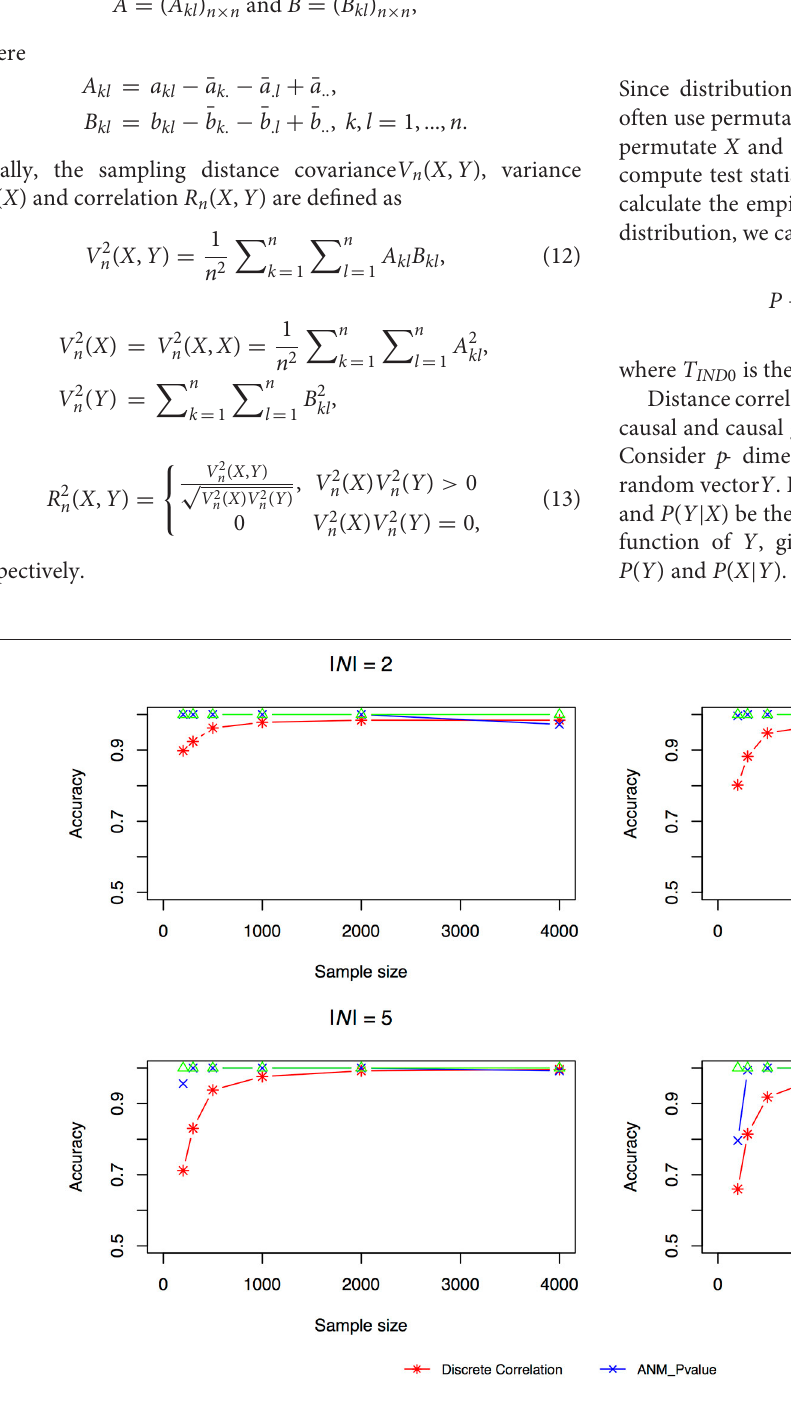
5. Simulation scenario 4, |N| =